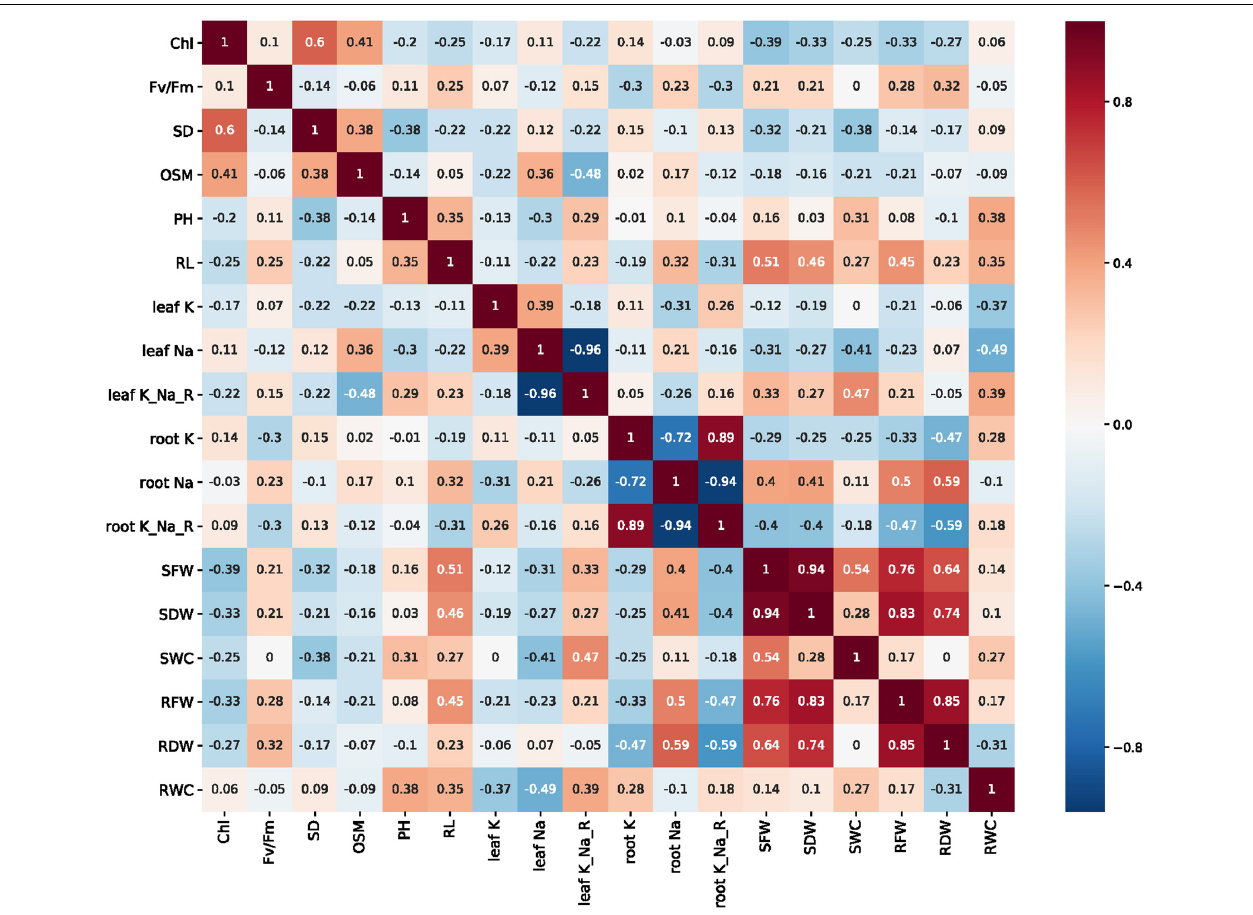
FIGURE 4 | Correlation map of the 18 traits based on Spearman correlation analysis (positive, red; negative, blue. Non-significant ( p ≥ 0.05) values are indicated by blank